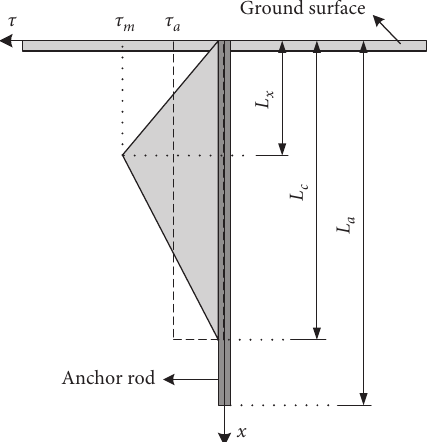
Figure 24: Simplified model for the shear stress of the first